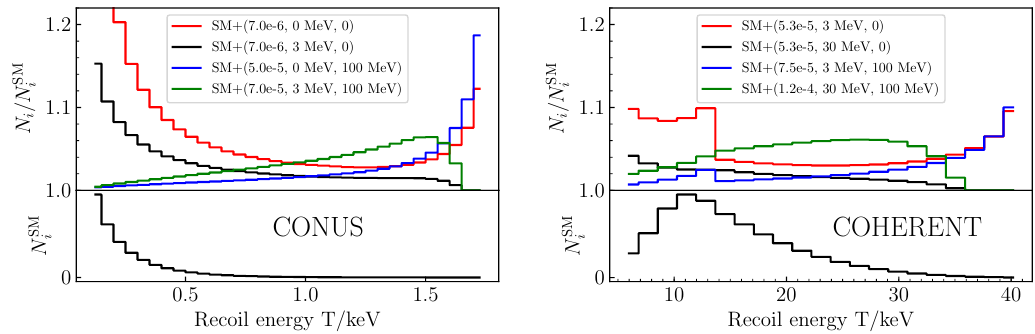
Figure 3 . Event distributions and spectrum distortions due to the new channel ( (cid:23)N (cid:31)N ) in ! CONUS (left) and COHERENT (right). N SM and N i are the event numbers for SM-only and SM i plus new physics, respectively. In the upper panels the ratio of the total and SM-only event rate is shown with the corresponding ((cid:22) y; m (cid:31) ; m S ) indicated in the parentheses. In the lower panels we indicate the recoil spectrum of the SM process in arbitrary